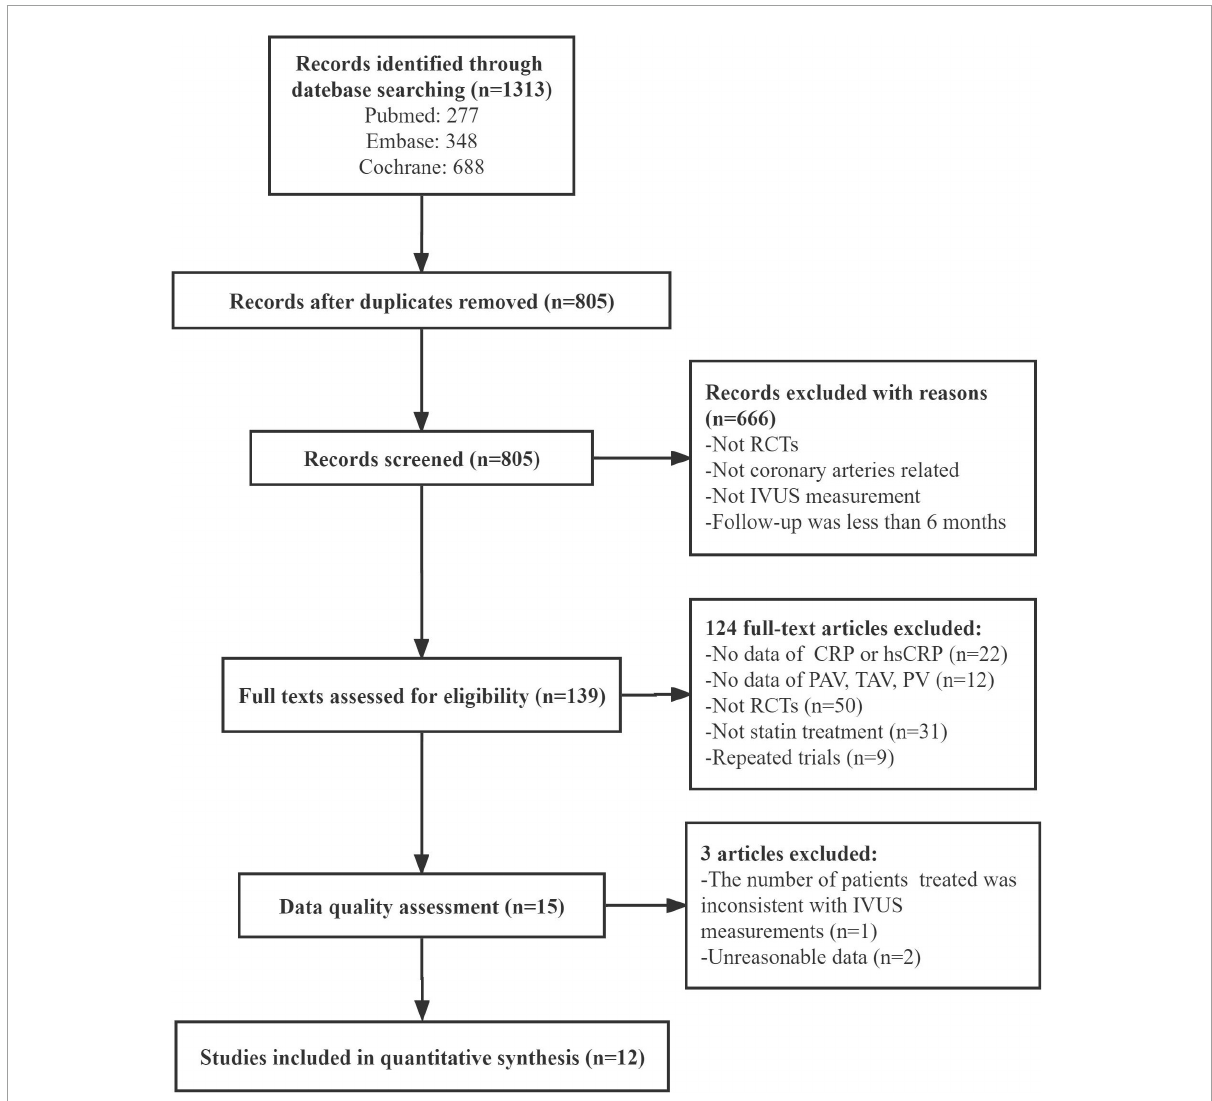
FIGURE1 Flowchart for study. RCTs, randomized controlled trials; IVUS, intravenous ultrasound; CRP, C-reactive protein; hsCRP, high-sensitivity C-reactive protein; TAV, total atheroma volume; PAV, percent atheroma volume; PV, plaque volume.